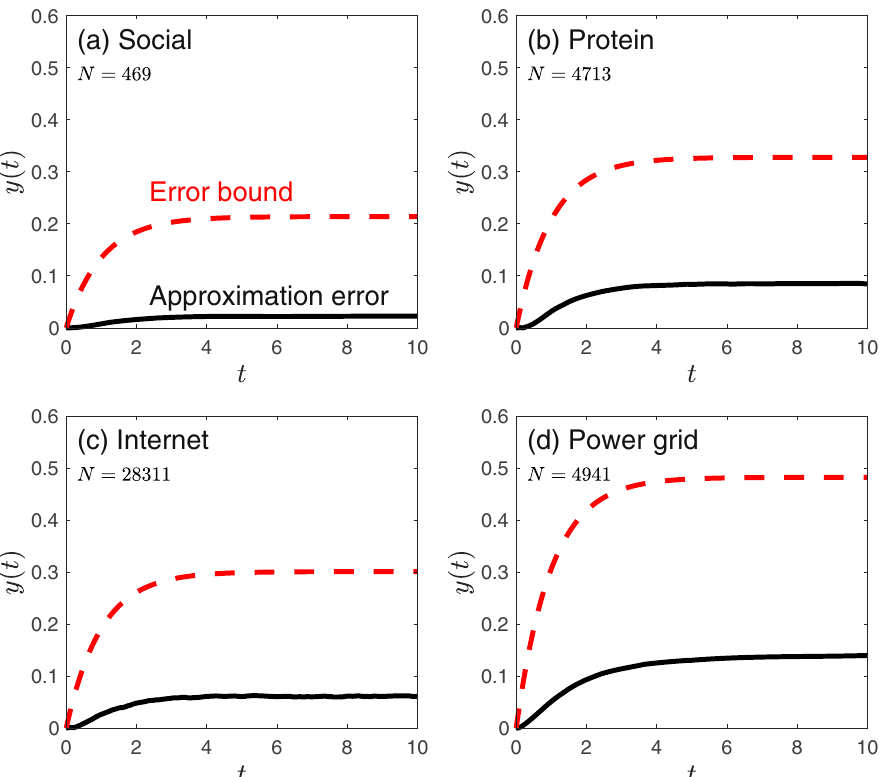
Fig. 3 Comparison of susceptible – infected – susceptible with ambient infections (SISa) mean- fi eld approximation error with theoretical upper bound on four real-world networks. Comparison of the evolution of the mean- fi eld approximation error y ( t ) over time t for the SISa model (solid black line), computed using stochastic simulations, with our theoretical bound (dashed red line) for four real-world networks. a Uses the Haselmere 1m network 34,35 , b uses a protein interaction network 36 – 38 , c uses an autonomous-systems Internet network 39 and d uses a US power grid network 40 .